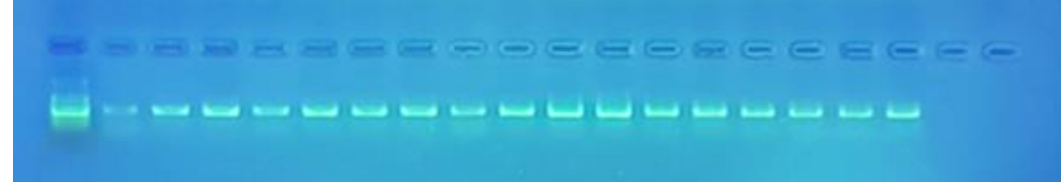
Figure 1. PCR results confirming A. thiooxidans bacteria. From left: first channel marker, second positive control; two last channels, negative control.